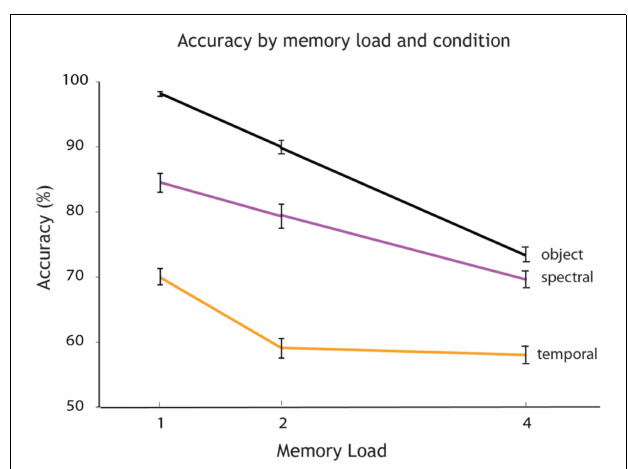
FIGURE 3 | Accuracy varies by memory load and experimental condition. Overall accuracy (percentage correct) for every memory load (1, 2, and 4 auditory objects presented within a sequence). The plot shows how accuracy decreases with an increase in memory load for each experimental condition: single feature spectral condition (in rose), single feature temporal condition (in orange) and object condition (in